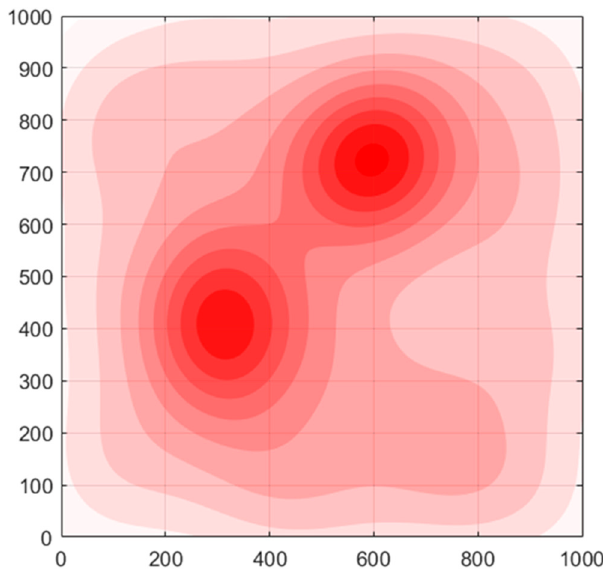
Figure 2. Example of threat density distribution in area of interest.